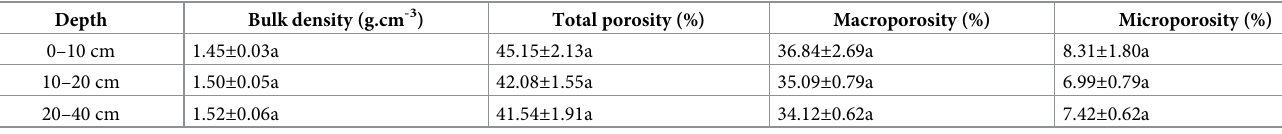
Table 1. Physical properties of the soil at different depths in the urban tree pits before the experiment. Depth